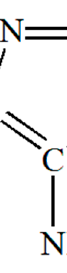
Figure 1. The chemical structure of 5-aminotetrazole.